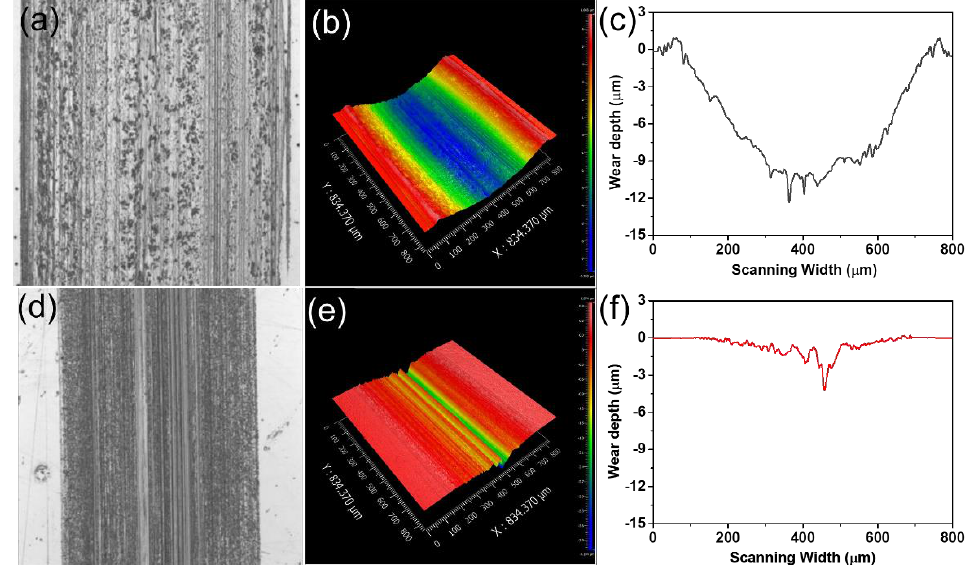
Figure 9. Optical microscope images, 3D morphology and cross section of the wear tracks on the steel disc lubricated by base grease ( a – c ) and the modified talc-based grease ( d – f ) under the high load of 450 N (80 °C).